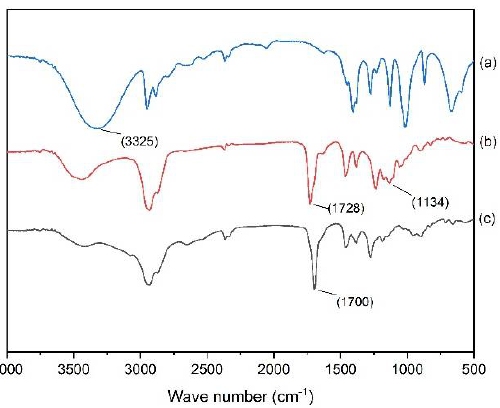
Figure 2. FT-IR spectra of ( a ) pentaerythritol ( b ) rosin ester ( c ) rosin.